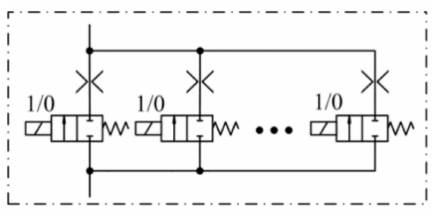
Figure 1. Parallel digital two-way